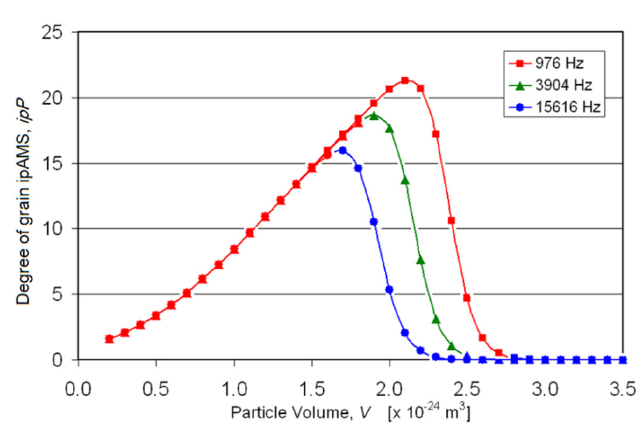
Figure 15. Variation in grain degree of ipAMS with magnetic particle volume and operating frequency in ultrafine particles.